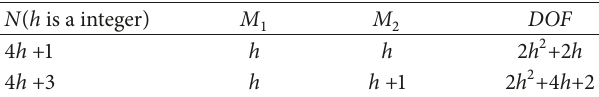
Table 1: The optimal configuration and DOF of the proposed nested